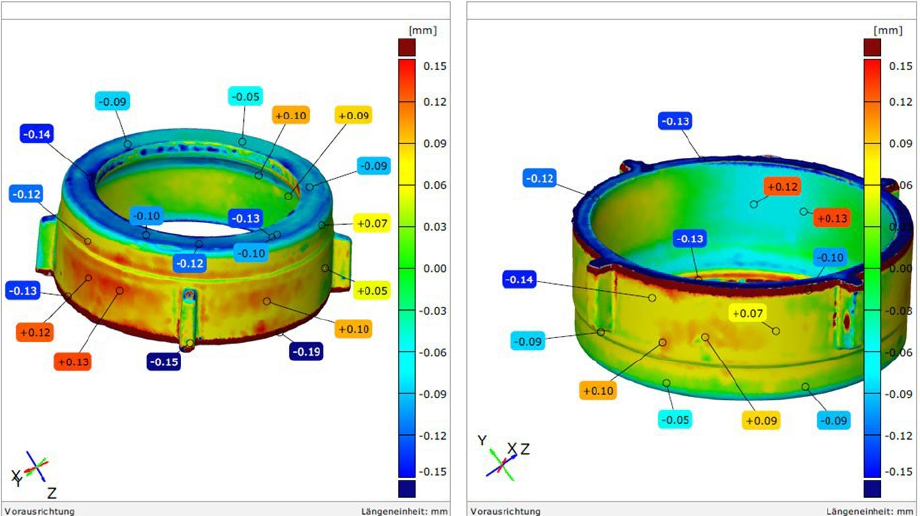
Figure 9. CAD false colour comparison of digitised wet rotor head made of CuZn39Pb3 and ZEP1510.